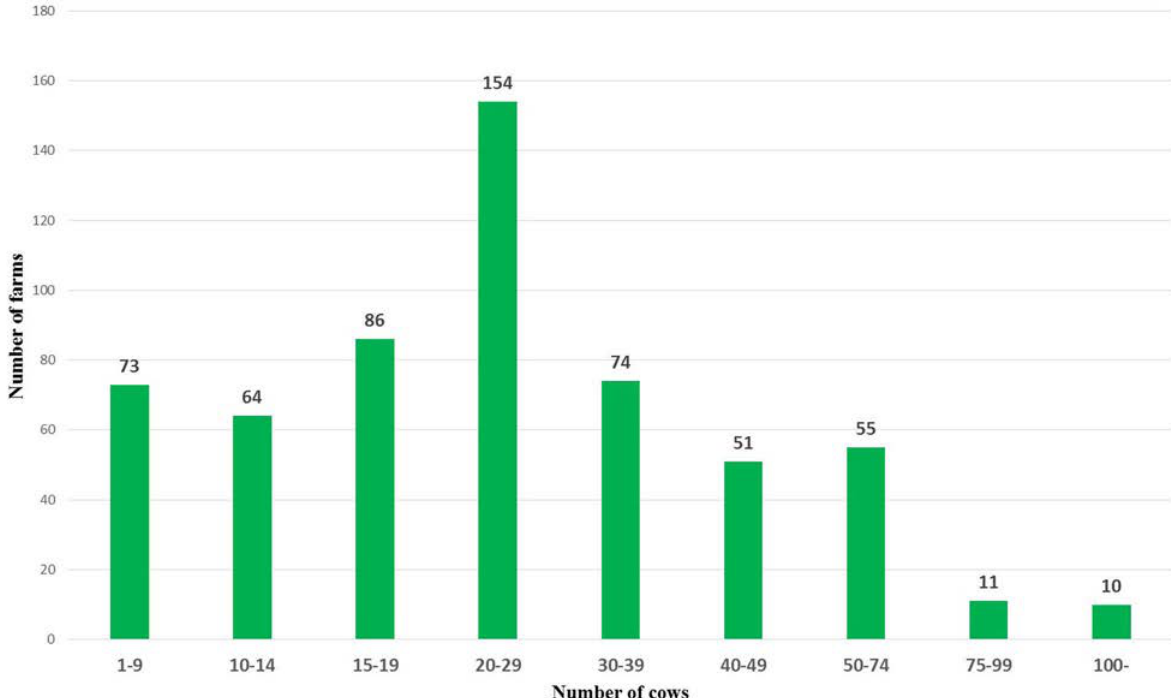
Fig. 2. Number of dairy cows per farm in North Karelia (2015). Source: Pro Agria